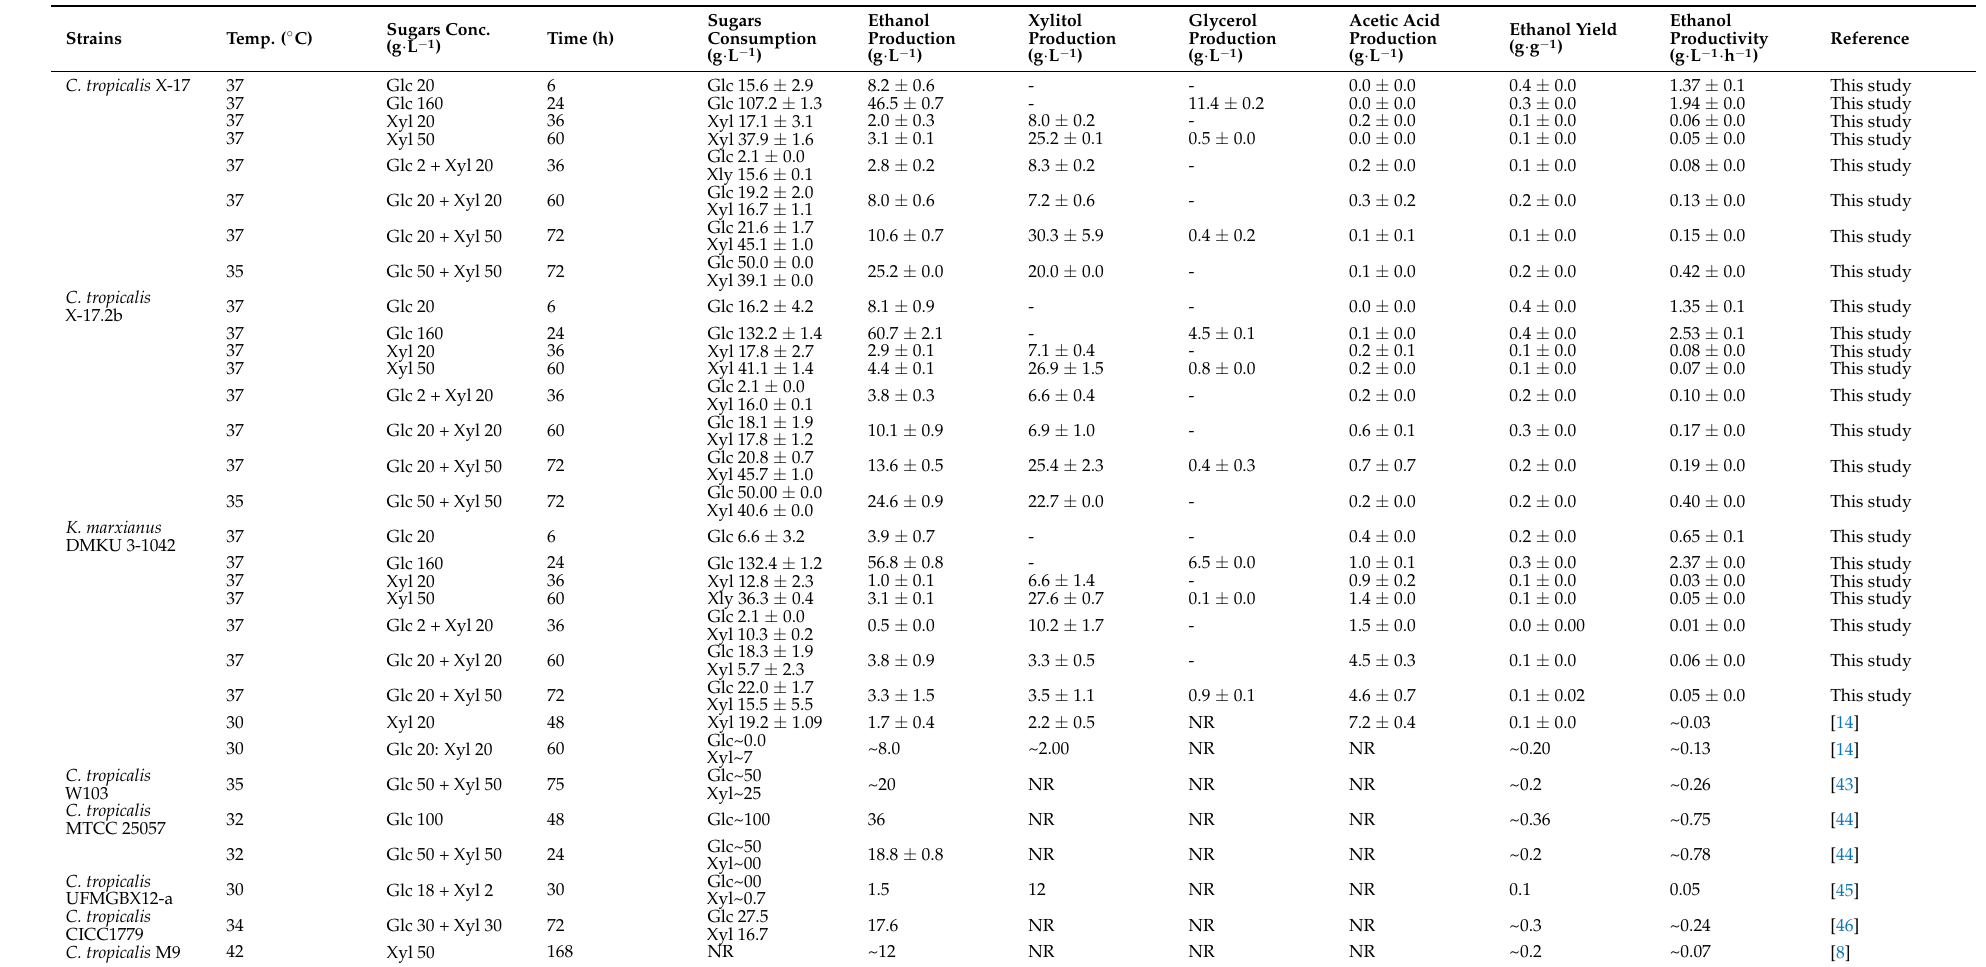
Table 2. Summary of fermentation abilities of C. tropicalis X-17, X-17.2b and K. marxianus DMKU 3-1042 and comparison with those of other C. tropicalis